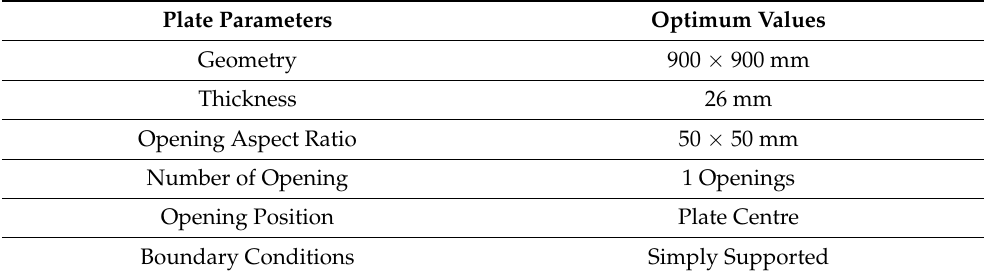
Simply Supported